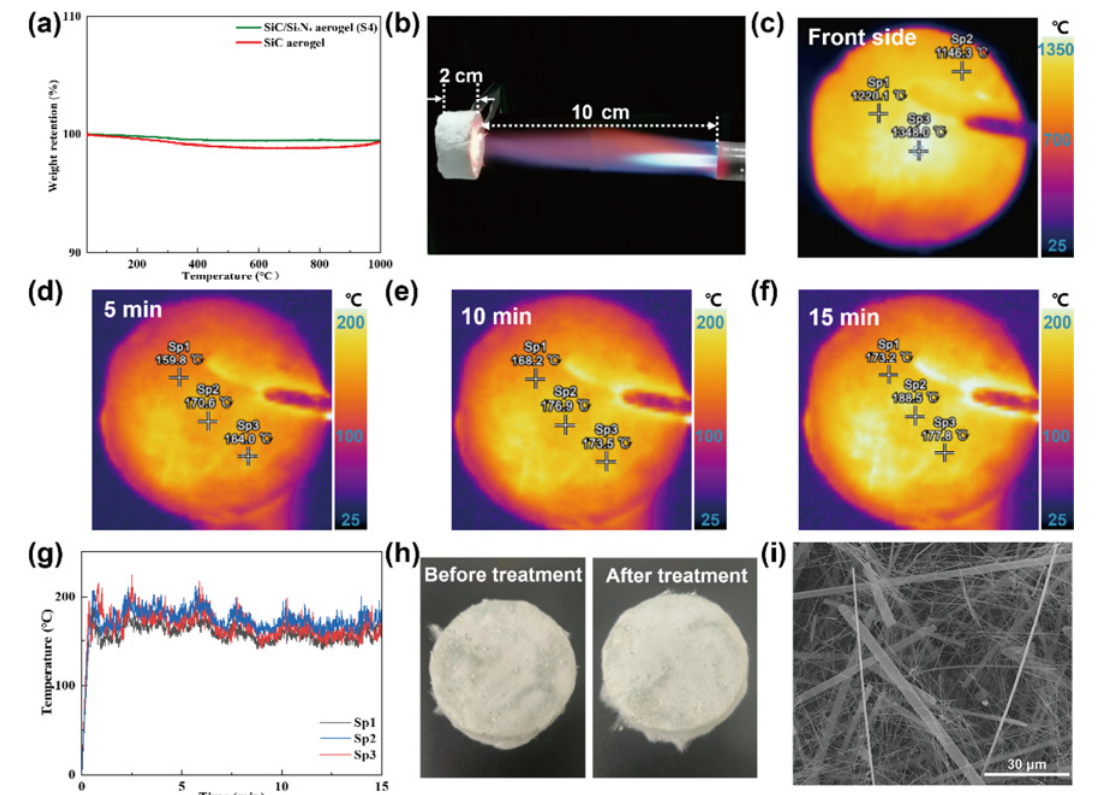
Fig. 8 High-temperature performances of the SiC/Si 3 N 4 composite aerogel. (a) Thermogravimetric curves of the SiC/Si 3 N 4 composite aerogel. (b) Optical images of SiC/Si 3 N 4 composite aerogel with density of 15 mg·cm − 3 exposed to a butane blowtorch flame. (c) Temperature distribution at the front of aerogel. Temperature distributions at the back of aerogel after (d) 5 min, (e) 10 min, and (f) 15 min. (g) Time-dependent temperature evolution of three reference points on the back side of the SiC/Si 3 N 4 composite aerogel. (h) Macroscopic morphology before and after ablation. (i) Microstructure of the aerogel after